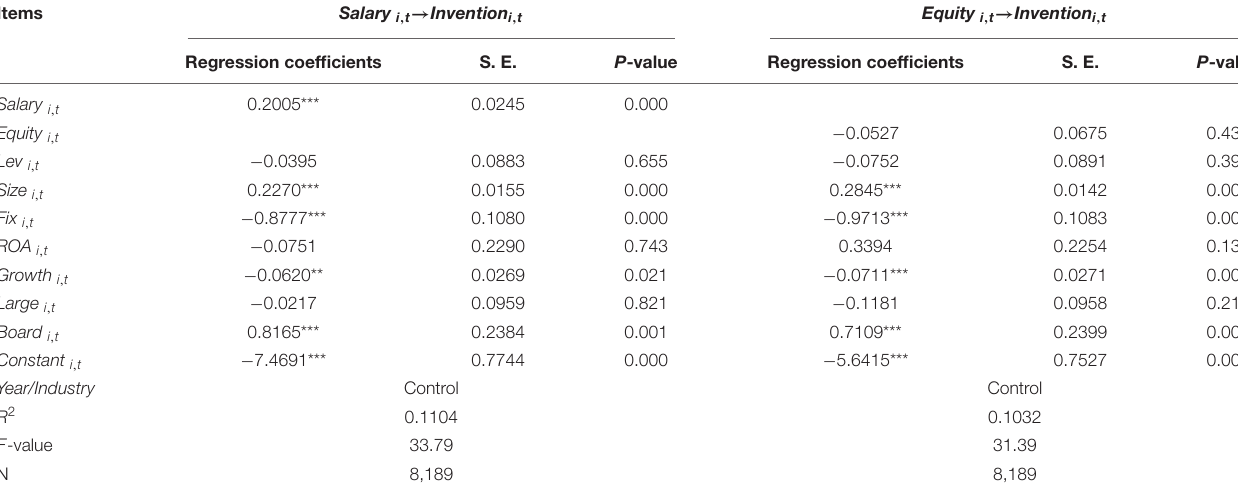
TABLE 8 | Managers’ incentive and corporate